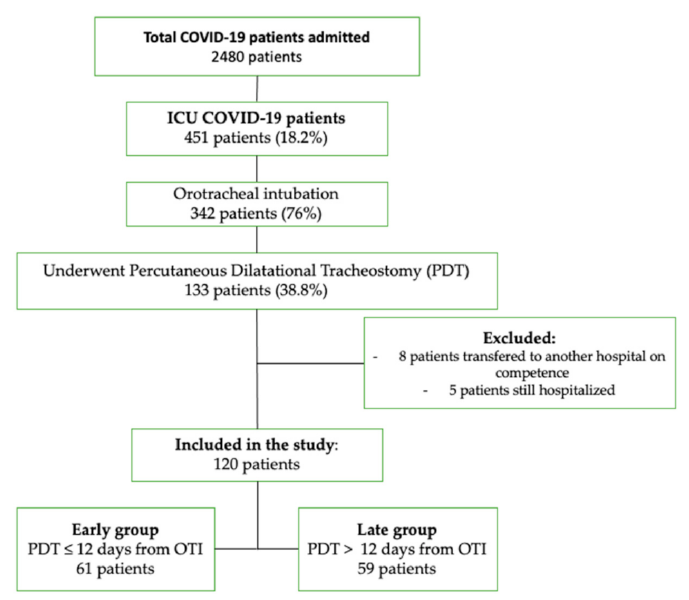
Figure 1. Flowchart of study selection. Abbreviations: ICU, intensive care unit; PDT, percutaneous dilatational tracheostomy; OTI, orotracheal intubation.